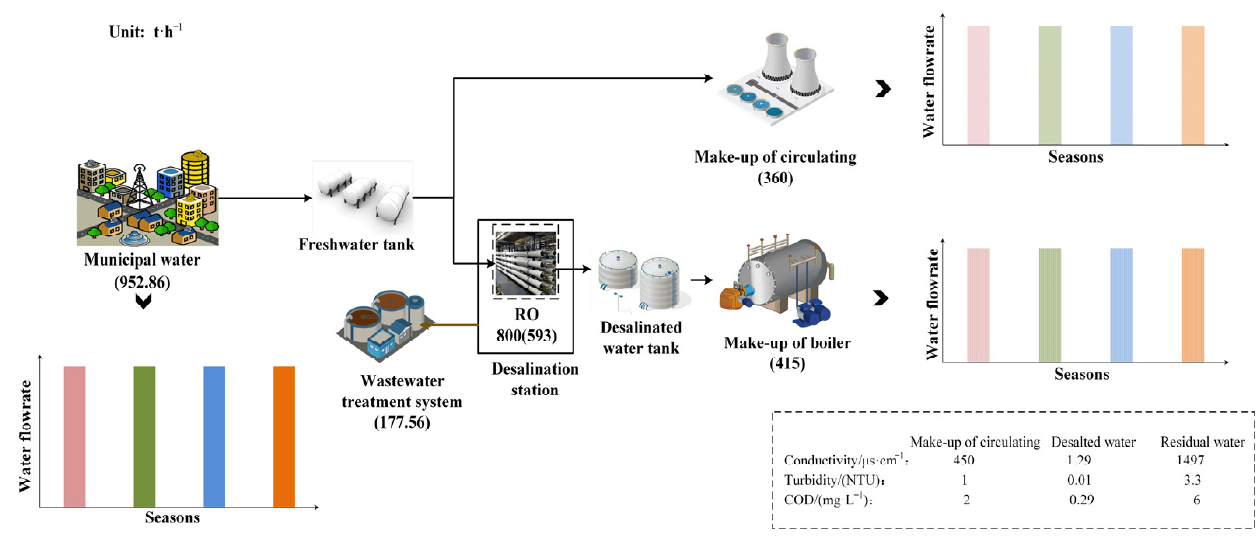
Figure 2. Optimal water supply network (Scenario 1).